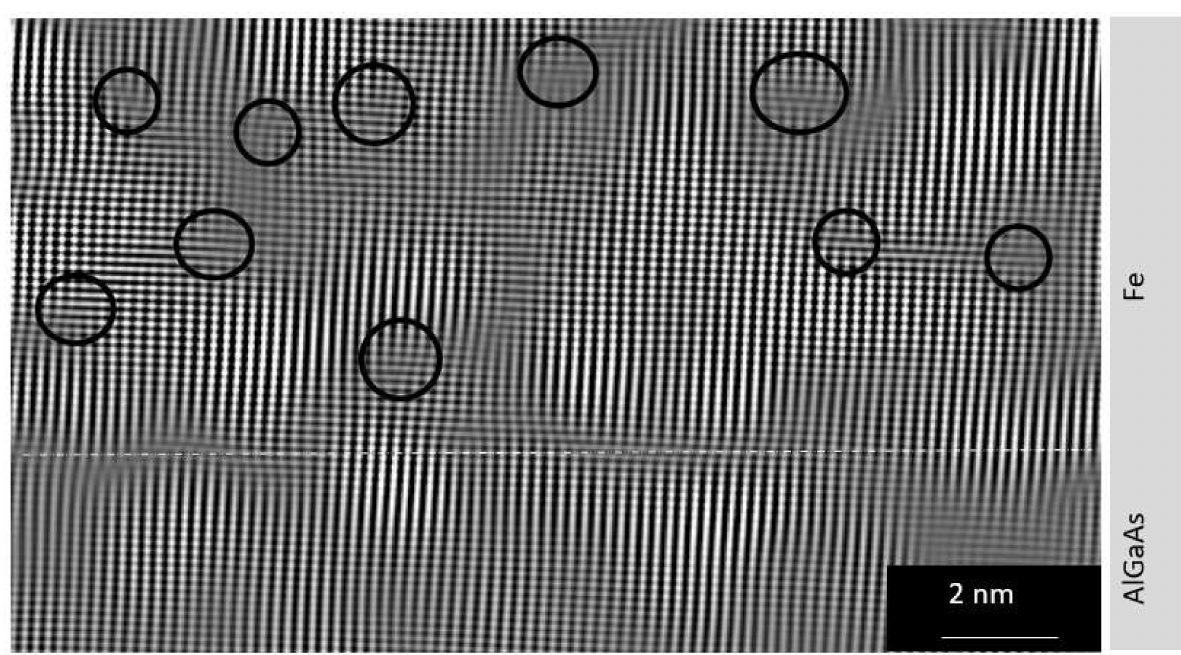
Figure 6. An IFFT image showing number of dislocations in Fe film deposited at room temperature. It has been reported that the interfacial doping or intermixing, which determines the shape of the Schottky barrier and band bending, influences the spin injection efficiency